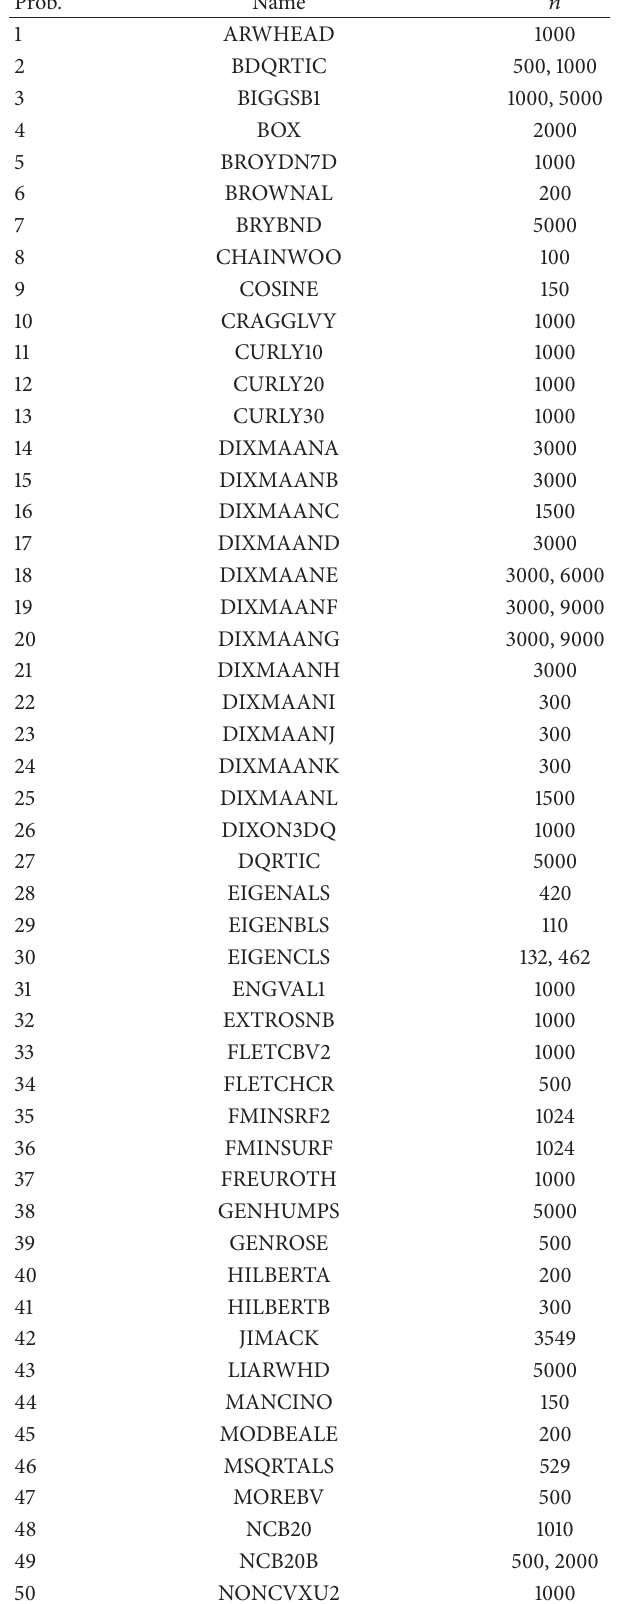
Table 1: List of test problems from the CUTEr library.